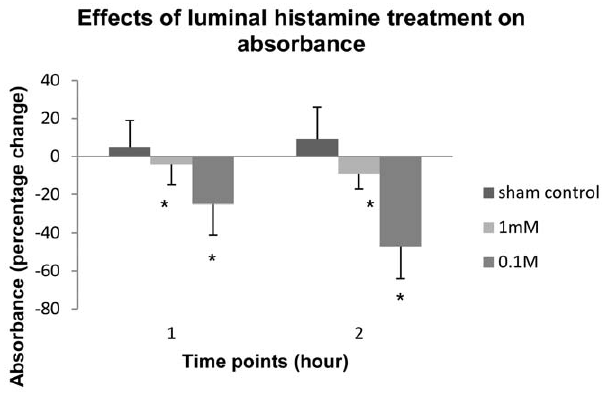
Figure 4. Luminal histamine treatments increase penetration of HRP in ovine vocal fold epithelium. Luminal histamine treatments significantly (P , 0.05) decrease absorbance of samples from the luminal chamber of Ussing system in a dose- and time-dependent manner. Data represent the mean and standard deviation of percentage change in absorbance. The baseline absorbance is 0.3604 6 0.1555 at 410